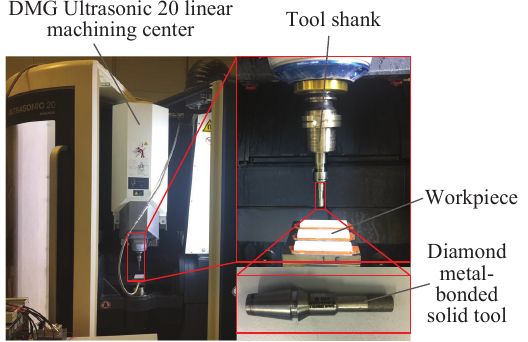
Figure 9. Experimental setup adopted for the UVAG experiments. The maximum spindle rotational speed with ultrasonic vibration was 10,000 min − 1 , while the maximum spindle rotational speed without ultrasonic vibration was 42,000 min − 1 . The vibration frequency varied from 20 kHz to 50 kHz for the different tool-workpiece sys- tems adopted. The vibration amplitude was measured by a laser vibrometer (Polytec